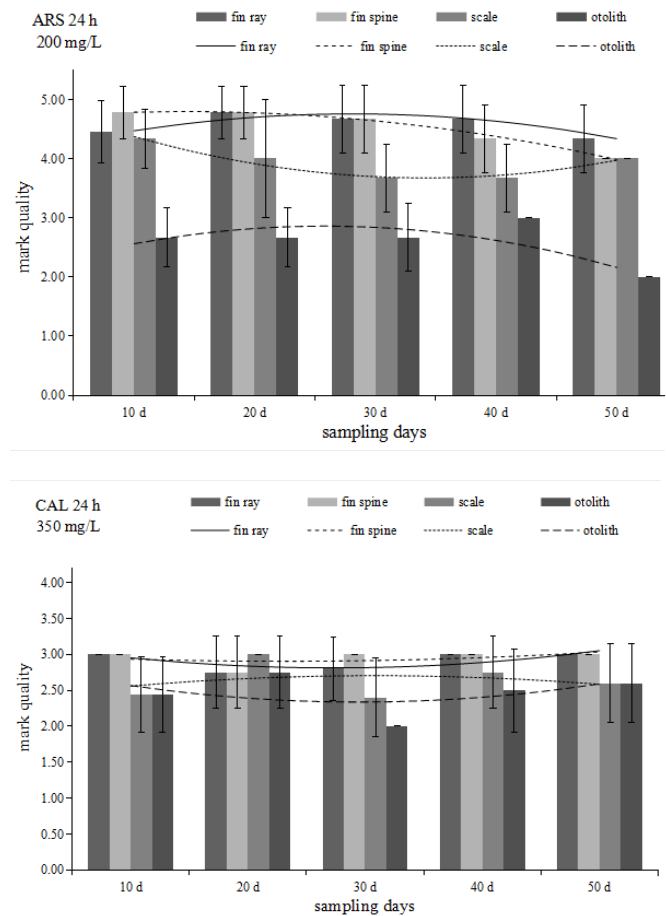
Figure 3. Effects of marking in the fin ray, fin spine, scale and otolith of black sea bream subjected to ARS (200 mg/L) and CAL (350 mg/L) treatment for 24 h. Data were collected on the 0, 10th, 20th, 30th, 40th and 50th day of the growth experiment.